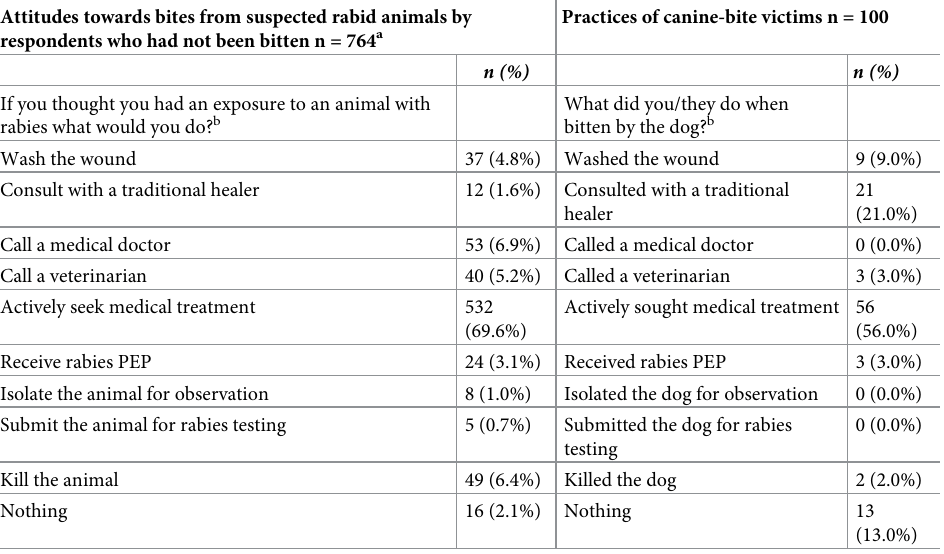
Table 4. Attitudes and practices concerning post-bite healthcare-seeking behavior categories among community members, Uganda, 2013. Attitudes towards bites from suspected rabid animals by respondents who had not been bitten n = 764 a If you thought you had an exposure to an animal with rabies what would you do? b Wash the wound 37 (4.8%) Washed the wound 9 (9.0%) Consult with a traditional healer 12 (1.6%) Consulted with a traditional Call a medical doctor 53 (6.9%) Called a medical doctor 0 (0.0%) Call a veterinarian 40 (5.2%) Called a veterinarian 3 (3.0%) Actively seek medical treatment 532 Submit the animal for rabies testing 5 (0.7%) Submitted the dog for rabies Kill the animal 49 (6.4%) Killed the dog 2 (2.0%)